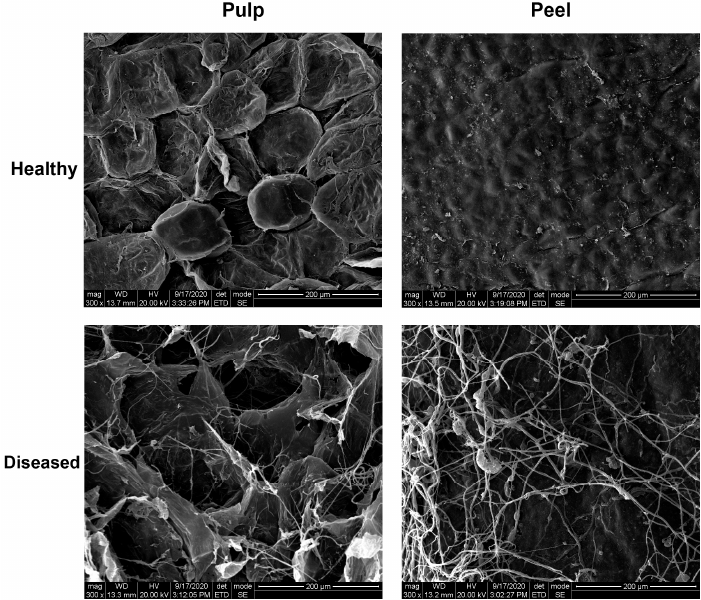
Figure 3. Scanning electron microscopy images of surface cellular characteristics for the pulp and peel tissues of healthy and diseased blueberry.